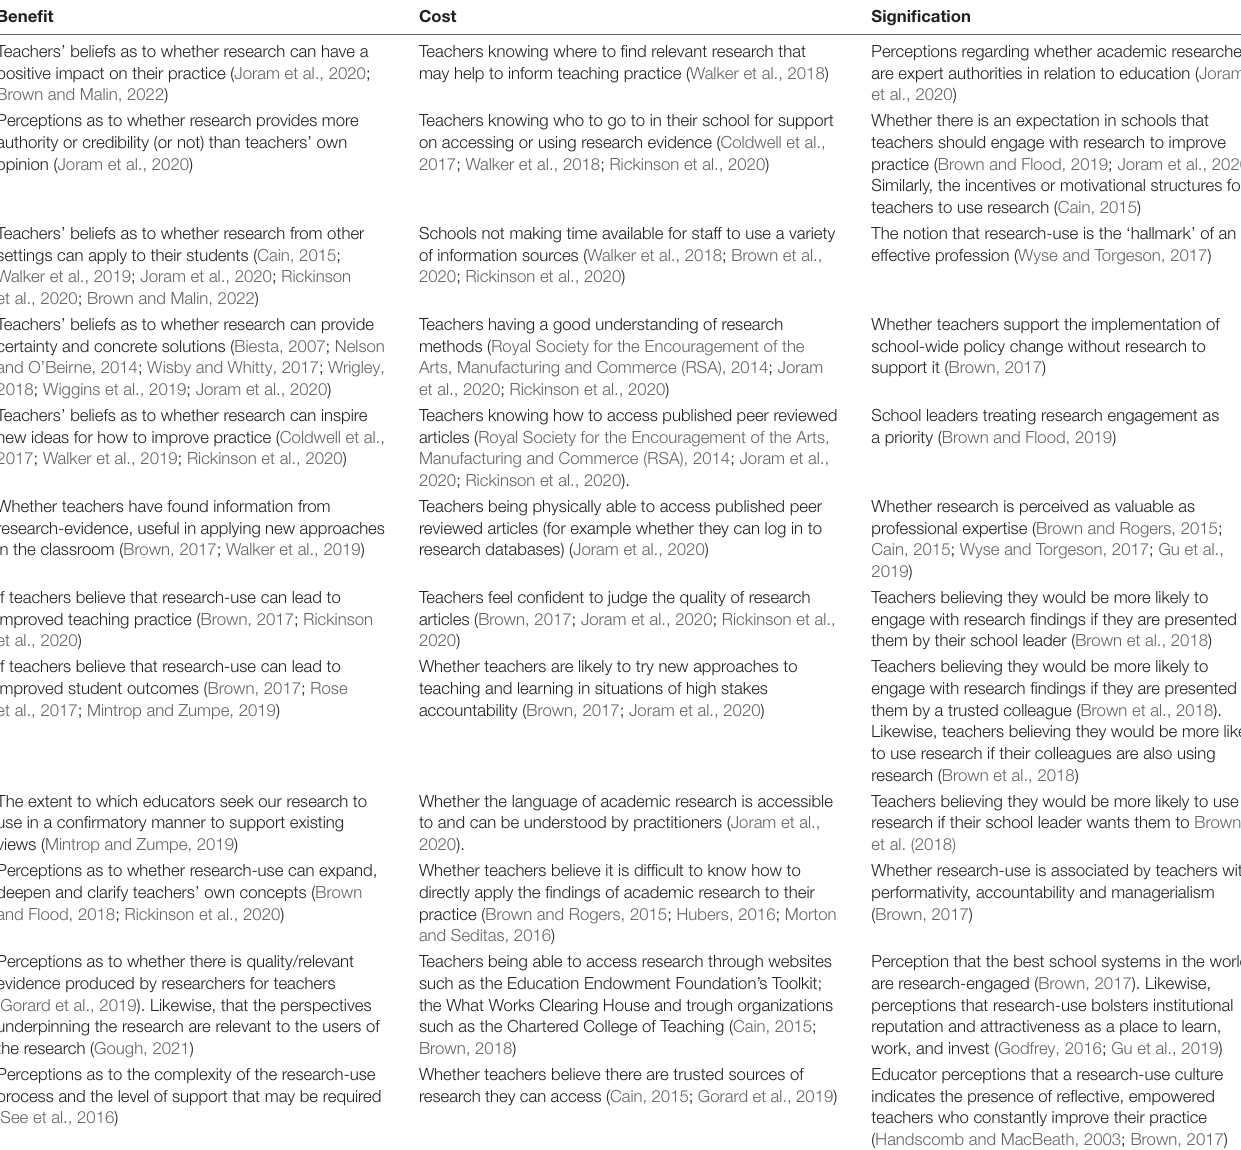
TABLE 1 | ‘Benefits,’ ‘costs,’ and ‘signification’ associated with research-use, identified from current research literature. Benefit Cost